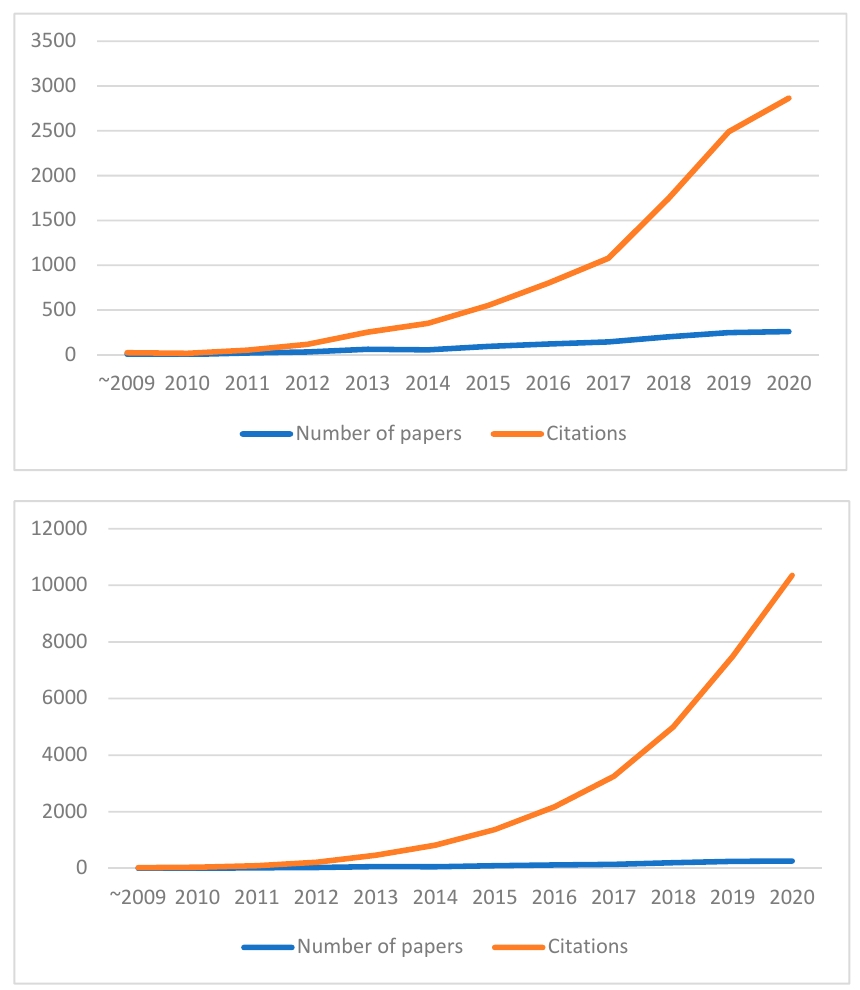
Figure 5. Proportion of the four main document types.